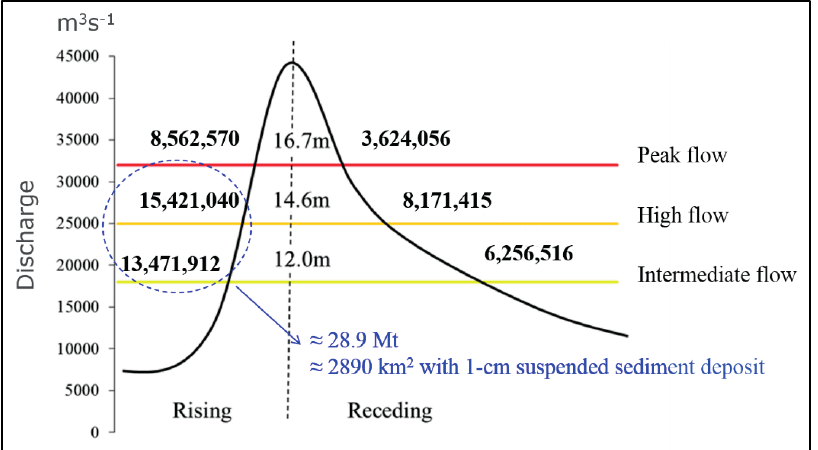
Fig. 6 Annual suspended sediment loadings (megatonnes, or Mt) in relation to river stage, discharge and flow conditions of the Mississippi River main channel at Tarbert Landing (~500 km from the river mouth to the Gulf of Mexico). SSL is higher on the rising limb than on the receding limb. The sum of SSL from the Intermediate Flow and High Flow stages on the rising limb (28.9 Mt) is nearly 25% of the annual total SSL of the Mississippi River, which could create a land area of 2890 km 2 with 1-cm deep deposit of suspended sediment (assuming a fresh sediment bulk density of 1 tonne m -3 ) if captured on